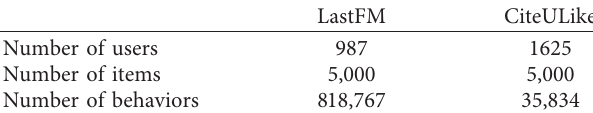
Table 1: Statistics of LastFM and